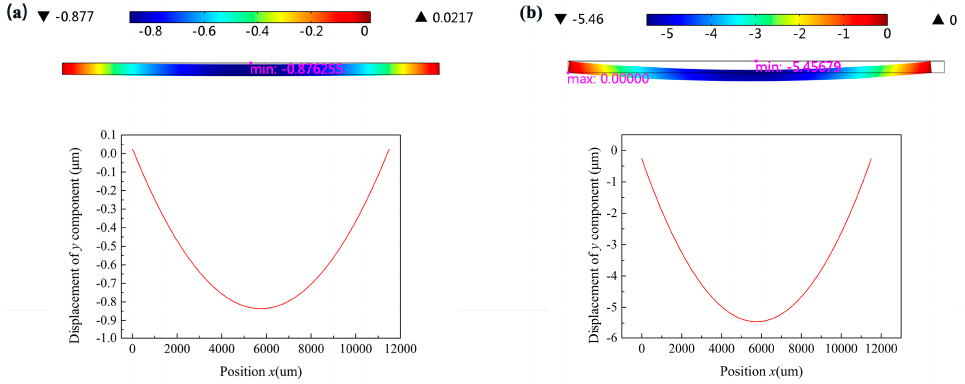
Figure 3. Displacement profiles of y component of the multilayer thin films. ( a ) Before deposition of SiN x ; ( b ) After deposition of SiN x film by plasma enhanced chemical vapor deposition (PECVD) with the original recipe (Plasma System100, Oxford Instruments).